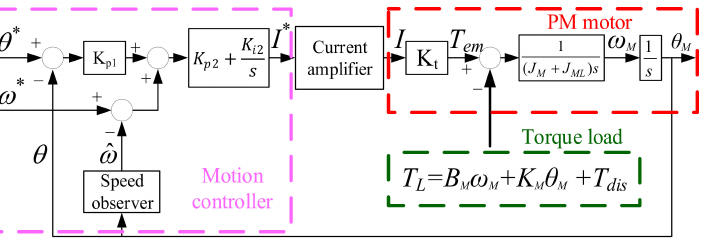
Figure 7. Standard PM motor motion control with position and speed feedback.